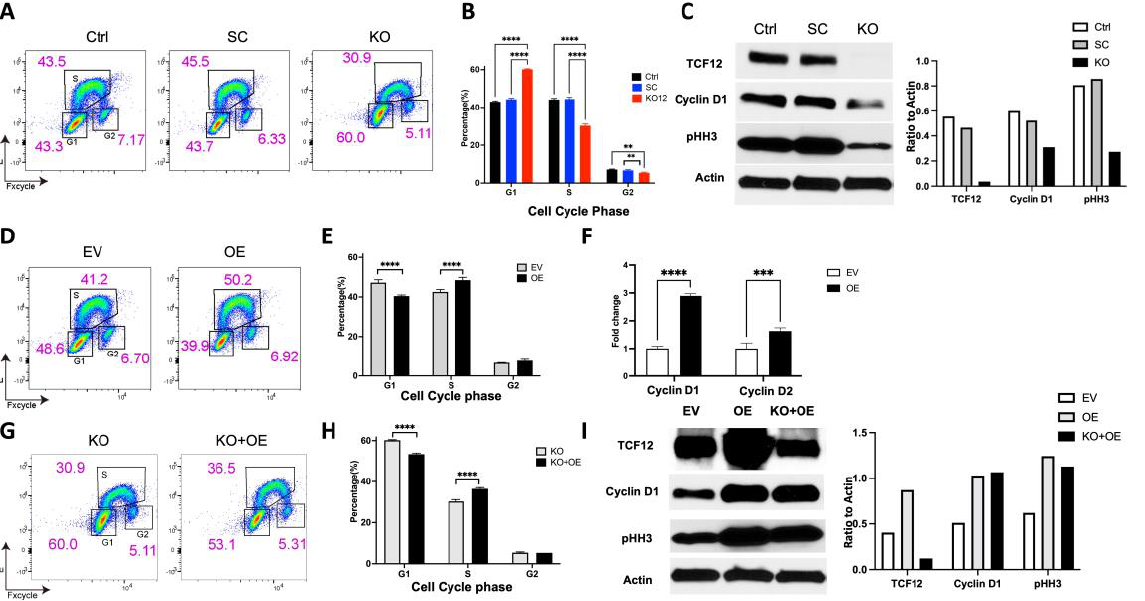
Figure 2. TCF12 regulates the cell cycle in GL261 cells. ( A ) Graphical representation of the flow cytometry data for EdU proliferations assay in Ctrl: control GL261 cells, SC: scramble cells, KO: TCF12 knockout GL261 cells. Cell cycle phases are indicated with the relative cell numbers in each phase. ( B ) Quantification results from A, n = 3 per cell type. ( C ) Western blot and quantification showing that complete knockout of TCF12 in GL261 cells causes lower protein levels of a cell cycle gene: cyclin D1; and a mitotic marker: pHH3. Actin is the loading control. ( D ) Graphical representation of the flow cytometry data of EdU proliferation assays for cells that received empty vector (EV), GL261 cells overexpressing TCF12 (OE). ( E ) Quantification results from ( D ), n = 3 per cell type. ( F ) qPCR data showing upregulation of key regulators of the cell cycle in TCF12-overexpressing GL261 cells compared to empty vector cells. ( G ) Graphical representation of the flow cytometry data for EdU proliferation assays in TCF12 KO cells (KO) and TCF12 GL261 KO cells that were complemented with TCF12 (KO+OE). ( H ) Quantification results from ( G ), n = 3 per cell type. ( I ) Western blot and quantification showing that overexpression of TCF12 restores TCF12 protein and increases the protein levels of cyclin D1 and pHH3. Ctrl: control GL261 cells, SC: scramble cells, KO: TCF12 knockout GL261 cells, EV: GL261 cells that received empty vector, OE: GL261 cells overexpressing TCF12, KO+OE: TCF12 KO GL261 cells in which TCF12 was restored. The uncropped blots ( C , I ) are shown in Figure S2. ** p < 0.01; *** p < 0.001, **** p < 0.0001 ( B , E , F , H